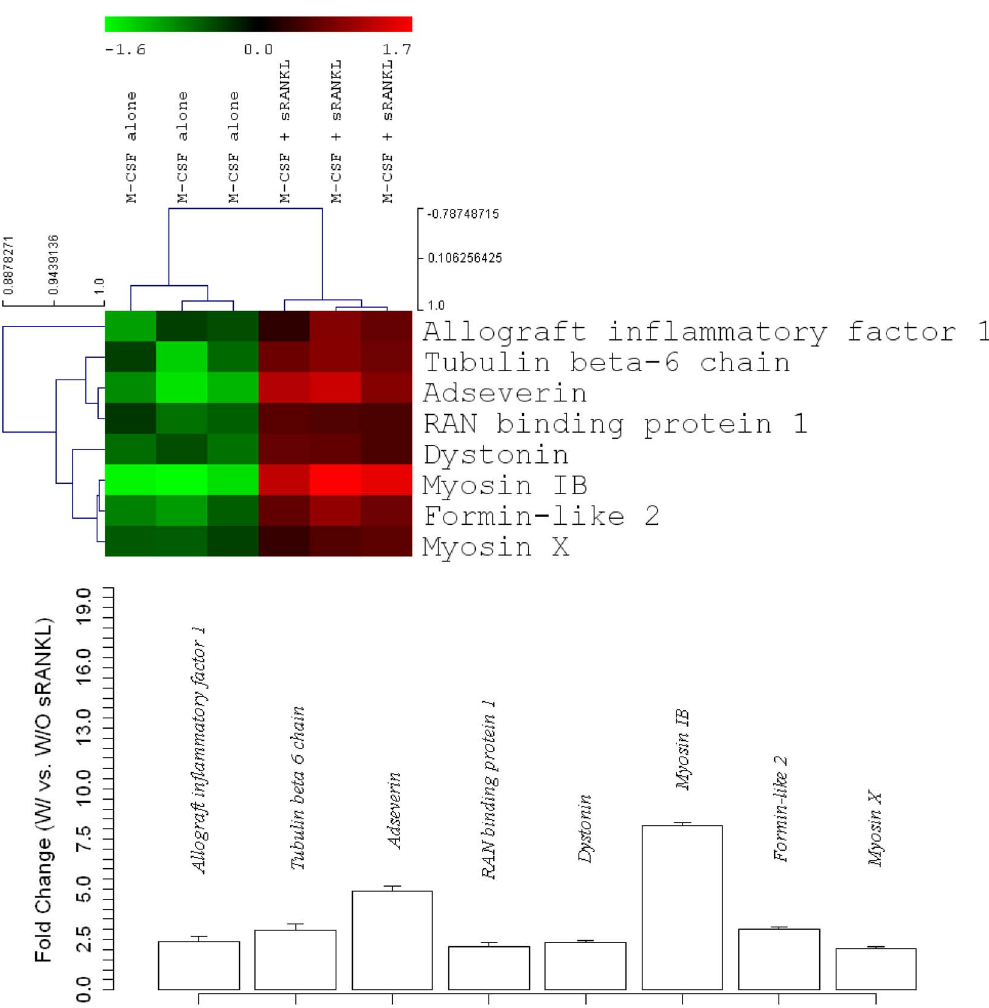
Figure 1. Microarray analysis identified Adseverin as a gene of interest during the early phases of OCG. Several genes were differentially expressed in osteoclast precursors stimulated for two days with sRANKL & M-CSF versus M-CSF alone. Eight cytoskeleton-associated genes with the greatest fold-change in expression (p , 0.05) were reported. Specifically, Ads was up-regulated 4.9-fold in osteoclast precursors stimulated with sRANKL for two days. The microarray data has been deposited in NCBI’s Gene Expression Omnibus and are accessible through GEO Series accession number GSE54779.